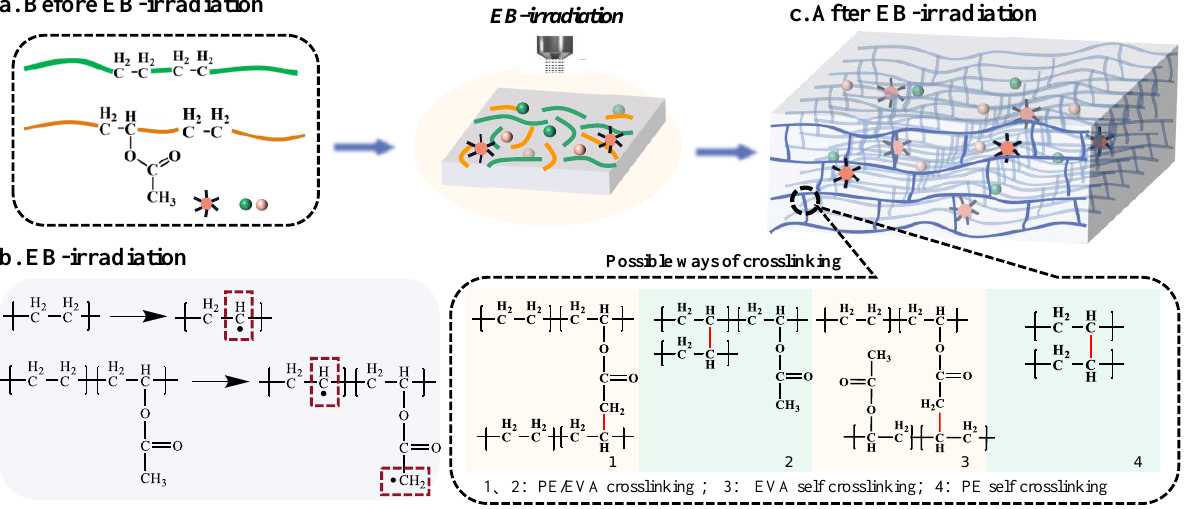
Figure 3. Illustration of crosslinked PE/EVA networks containing organic-inorganic flame retardants.